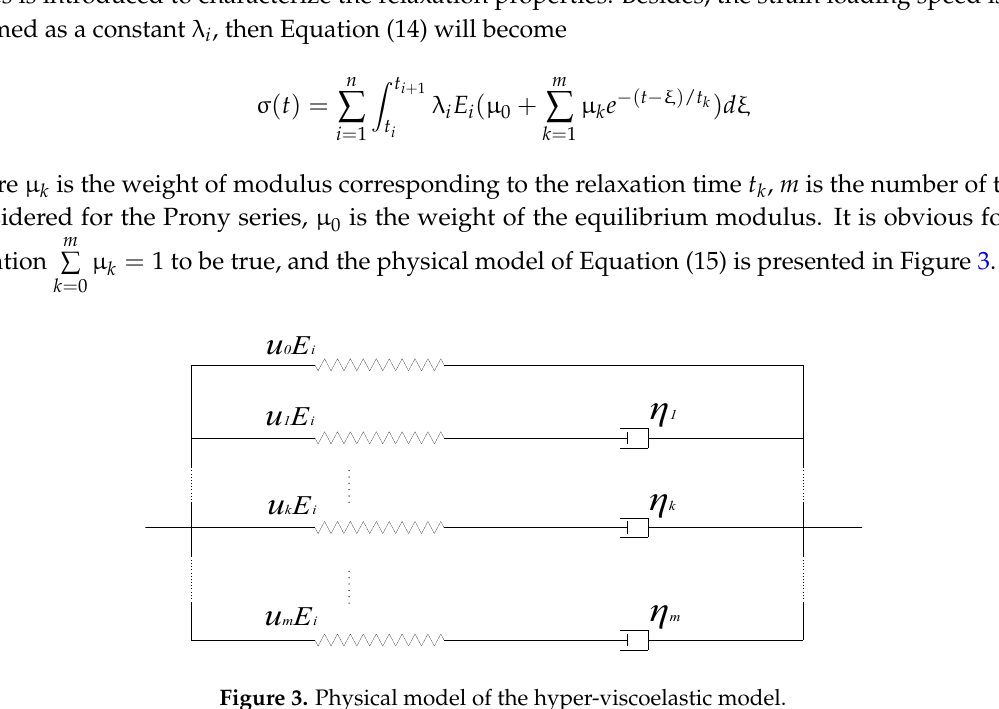
Figure 3. Physical model of the hyper-viscoelastic model.